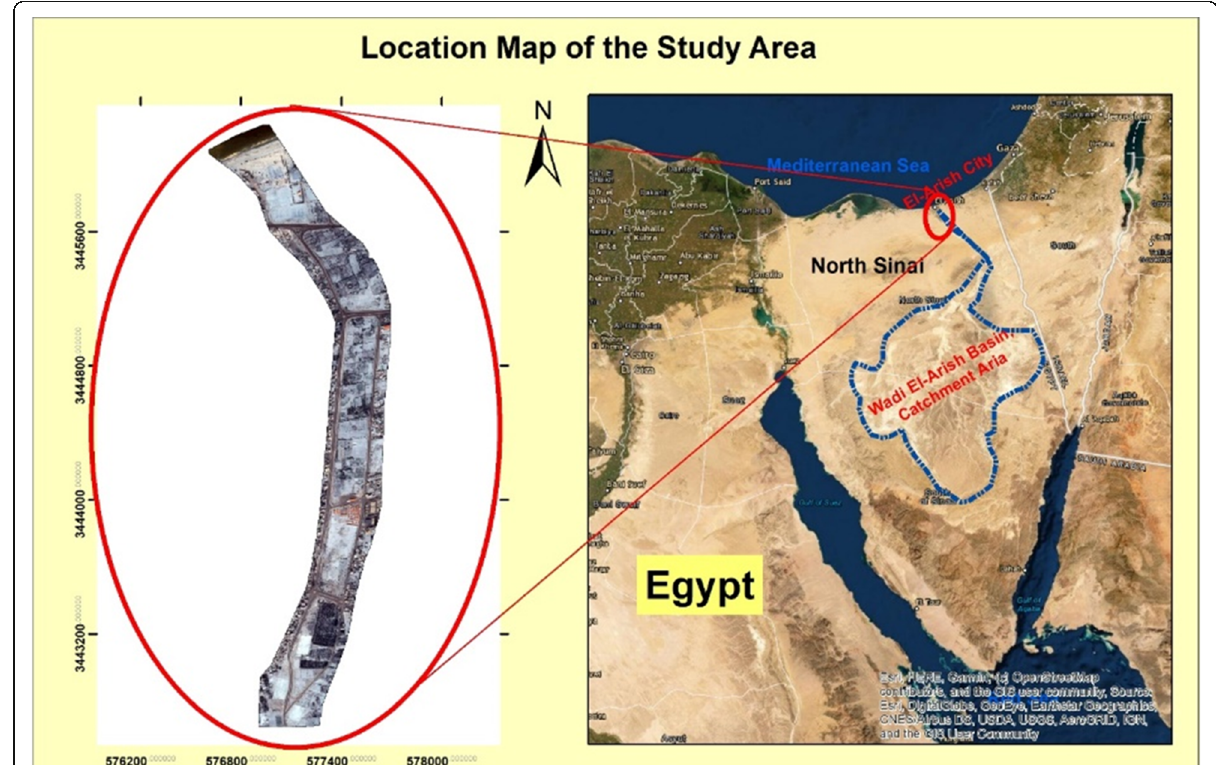
Fig. 1 Geographical location of the area of